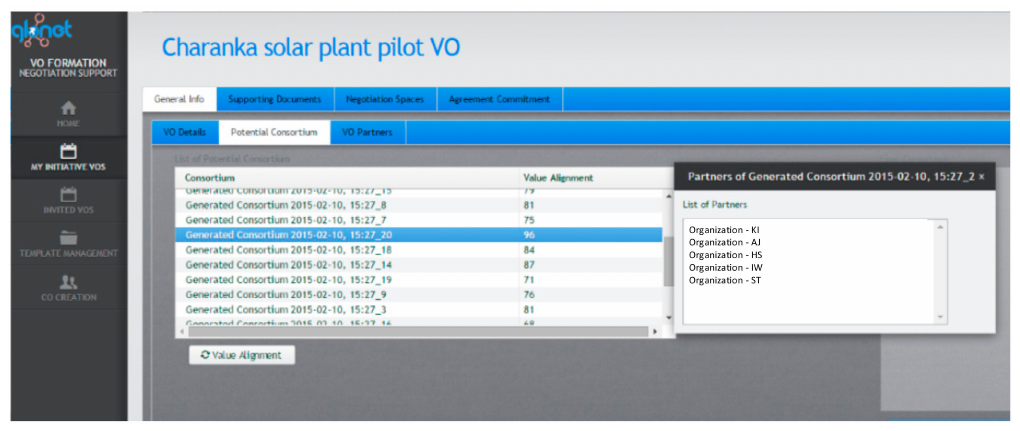
Figure 6. Potential Consortium Analysis.